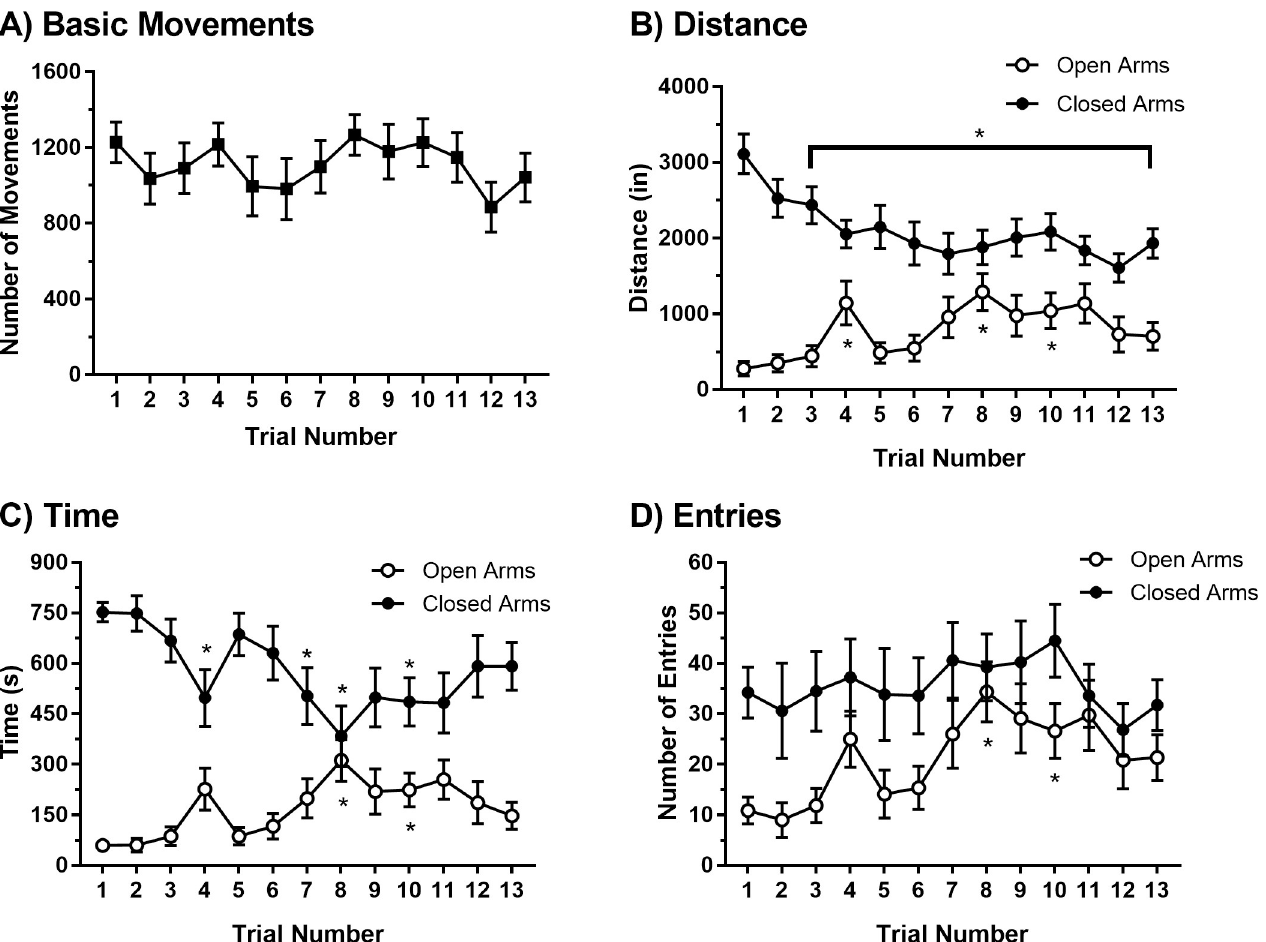
Fig 1. Behavior on the EPM varies across 13 trials relative to the first trial. Basic movements (A), open/closed arm distance (B), open/closed arm time (C), and open/closed arm entries (D) across 13 repeated EPM trials. Data are presented as mean and standard error (N = 8). Trials that significantly differ from Trial 1 are indicated by an asterisk ( �